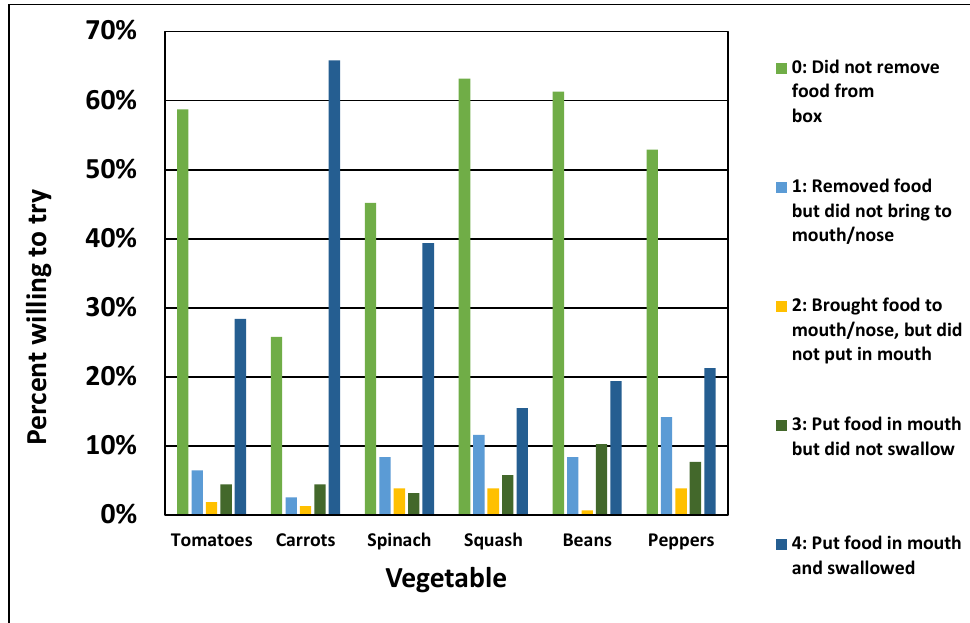
Figure 2. Percent of preschool children observed willing to try six vegetables according to the Farfan-Ramirez willingness to try (FR-WTT) scale.